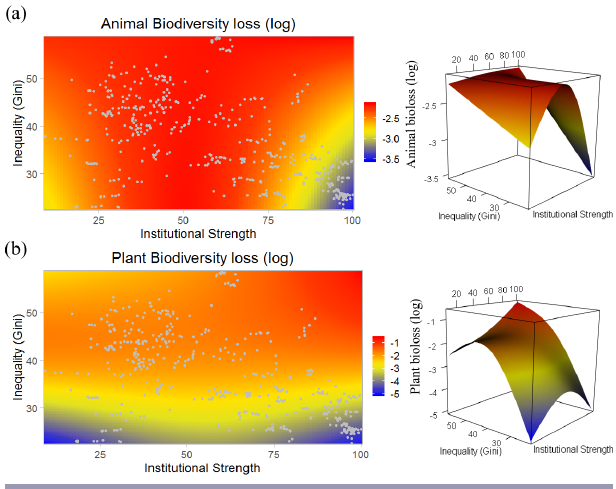
Fig. 4 . Trends in biodiversity loss due to inherent nonlinearities in inequality-institutions space. Red to blue regions show high to low biodiversity loss respectively. Biodiversity loss values predicted using a generalized additive model (GAM) with inequality-institutions interactions.